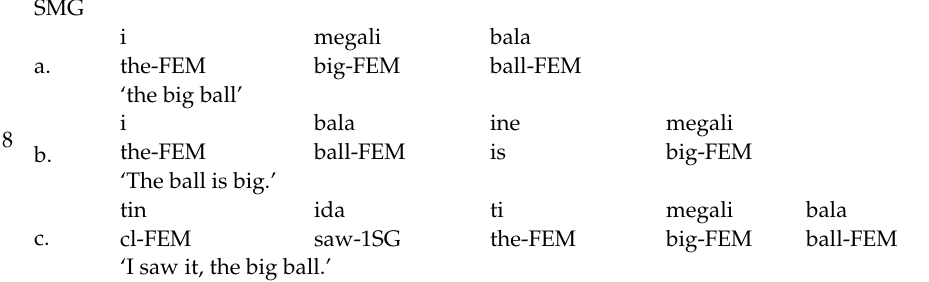
Table 4. SMG definite articles and clitic pronouns.